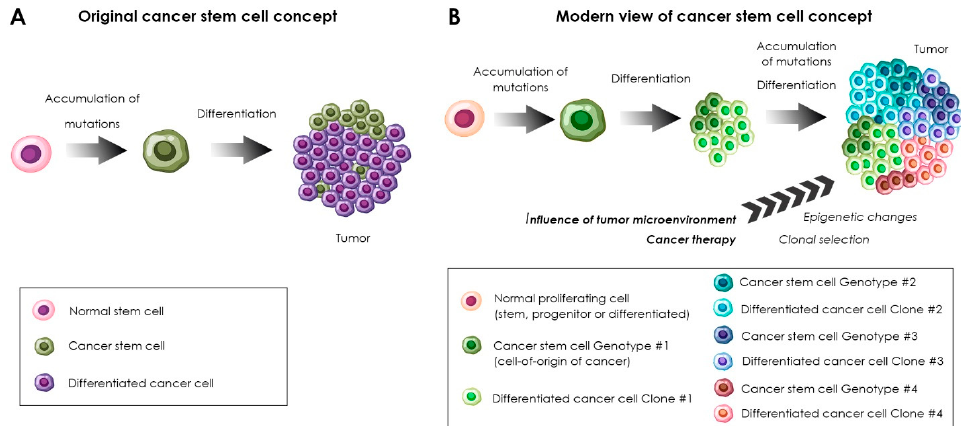
Figure 1. Evolution of the cancer stem cell concept. The original concept ( A ) emerged on the basis of the stem cell theory in its original form [19] and on the reports about the exclusive ability of tumor cells expressing stem cell markers to induce tumor growth [38,43]. The modern concept ( B ) has been updated by introducing the concept of the cells-of-origin of tumors [58,61] and according to data obtained by genetic analysis combined with CSC-associated marker profiling [24] and lineage tracing analysis [59,60,62,63]. Notably, the relationship between the cells-of-origin of cancer and the CSCs is yet not well understood and the characteristics of both cell types may dynamically